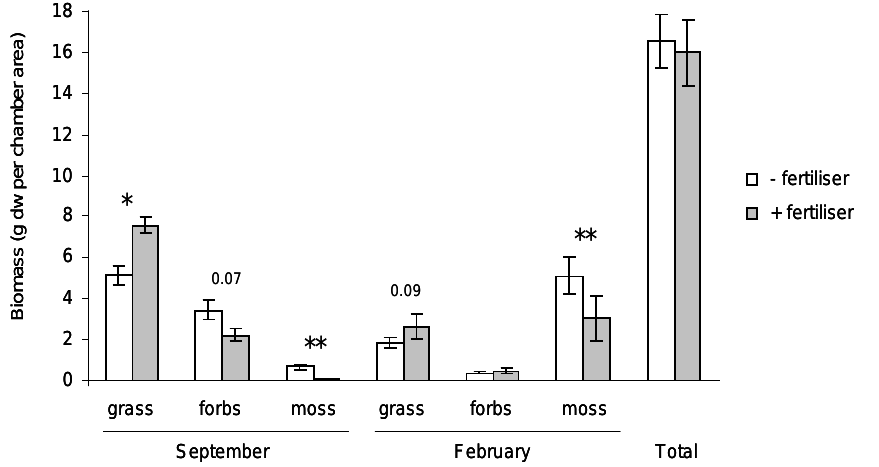
Fig. 1. Distribution of aboveground biomass over different plant groups in September and February in relation to fertiliser treatments. Values are means ± 1SE, significant differences between fertiliser treatments: * P < 0.05, ** P <